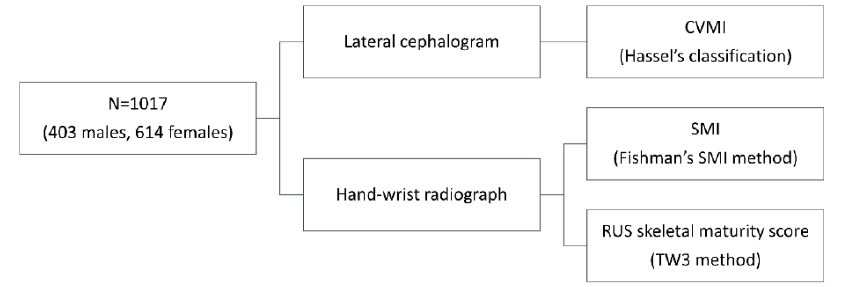
Figure 1. Schematic representation of the study